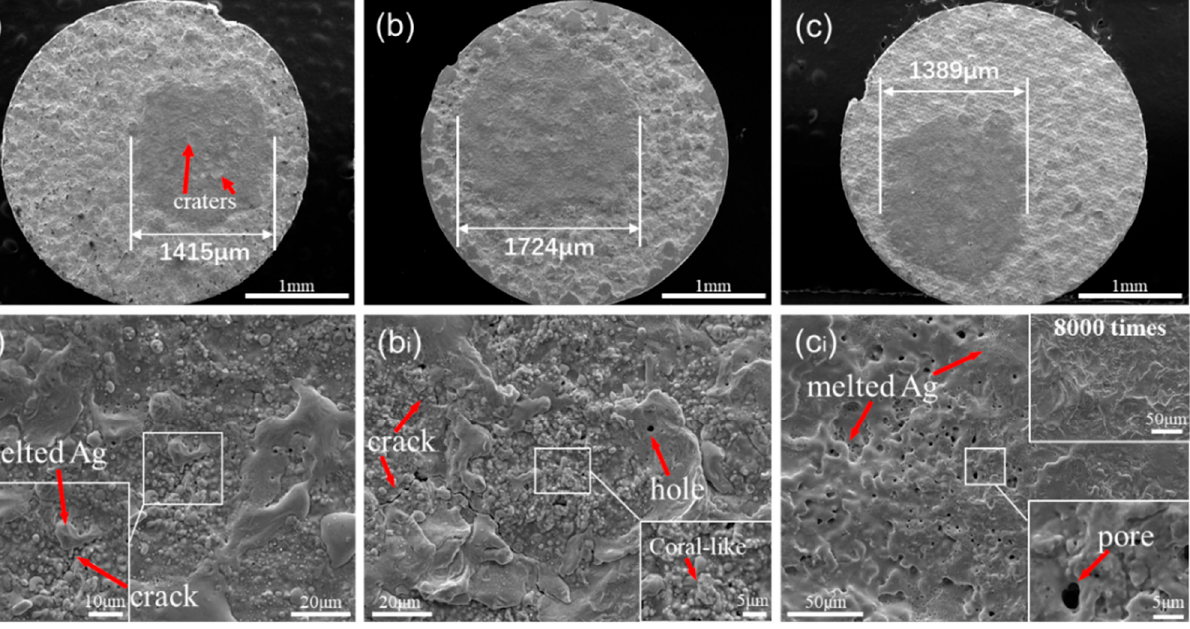
Figure 7. The surface morphologies after 10,000 arc erosion cycles of the ( a ) D-AgC, ( b ) A-AgC and ( c ) L-AgC, as well as the corresponding extended images ( ai , bi , ci ) for the erosion area.